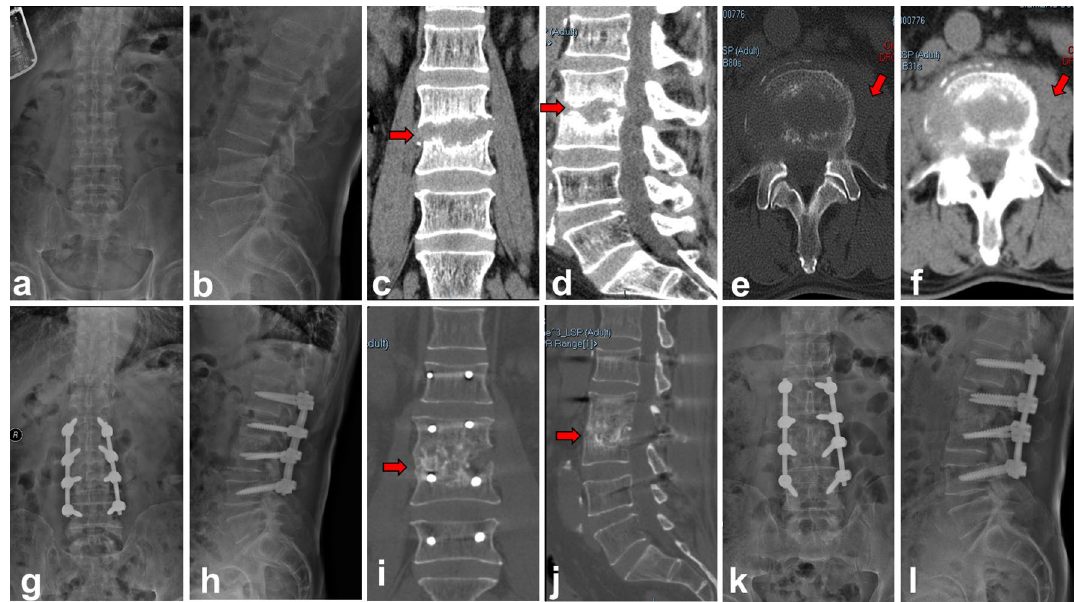
Figure 3. Autologous iliac bone group (group A). A 68-year-old male with L3–4 lumbar pyogenic spondylitis ( a – f ). Preoperative X-ray and CT showed that L3–4 vertebral body destruction with sequestrum formation, intervertebral space stenosis and psoas abscess (red arrow). ( g , h ) Postoperative X-ray showed iliac bone graft and internal fixations were in good location. ( i – l ) CT and X-ray taken at 6 months after operation showed solid bone fusion between L3 and L4.